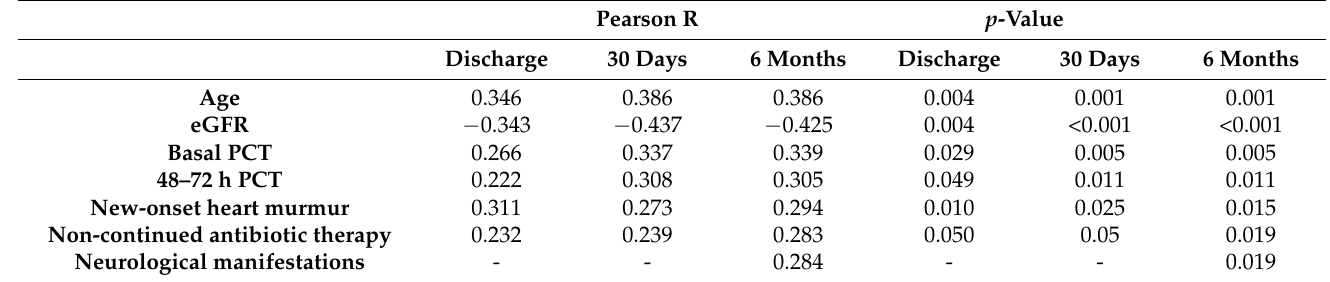
Table 4. Significant correlations between discharge, 1-month and 6-month mortality and characteristics of patients.